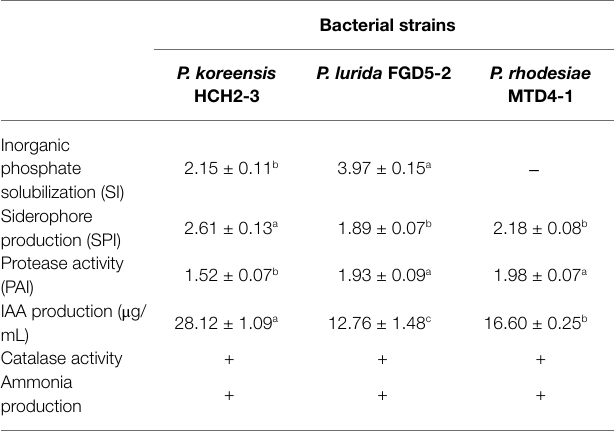
TABLE 1 | The in vitro plant-growth-promoting potential of three Pseudomonas